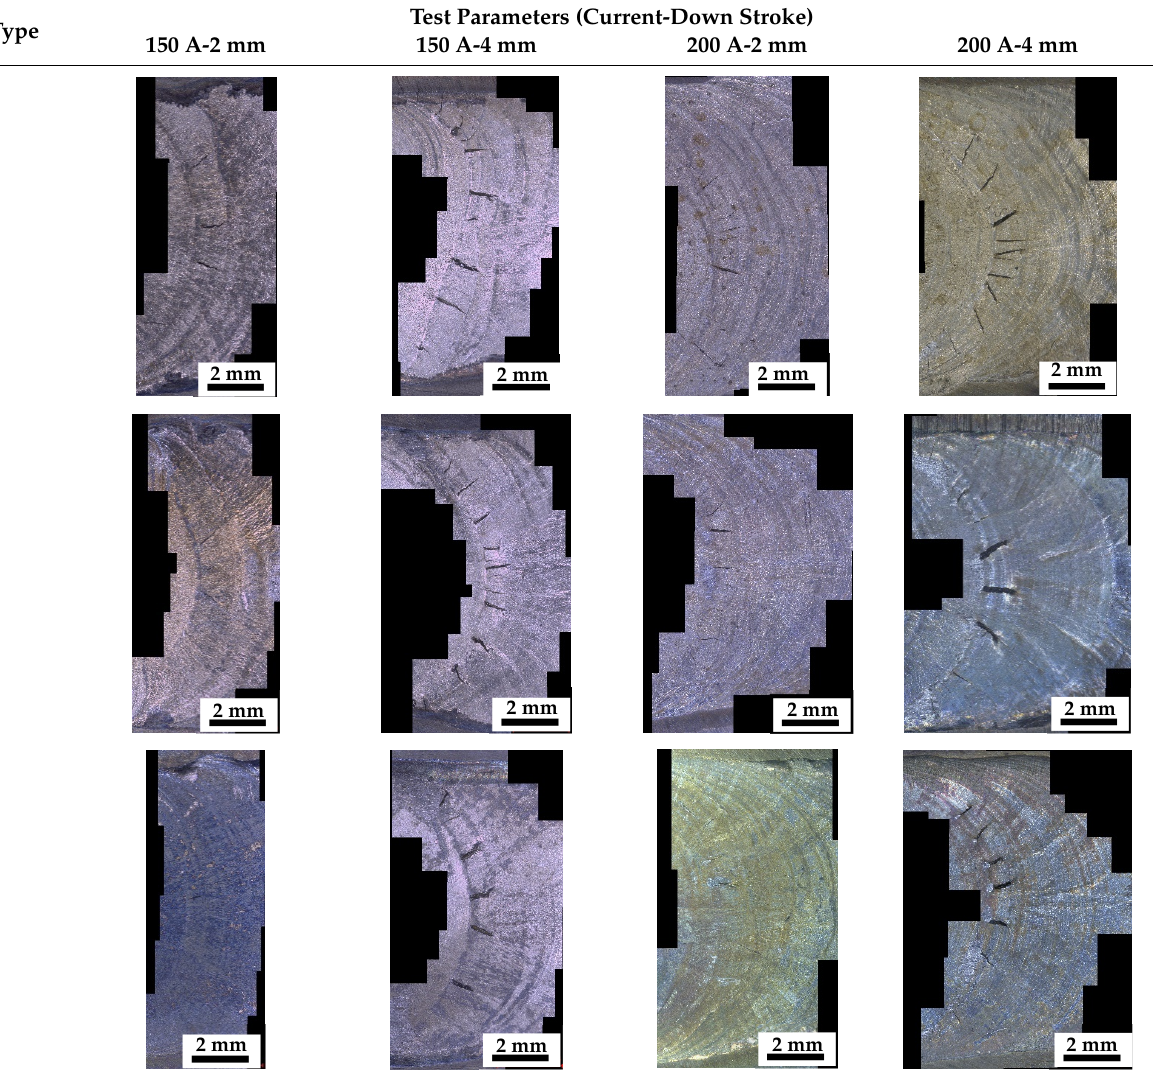
Table 5. Crack characterization of the Varestraint test.